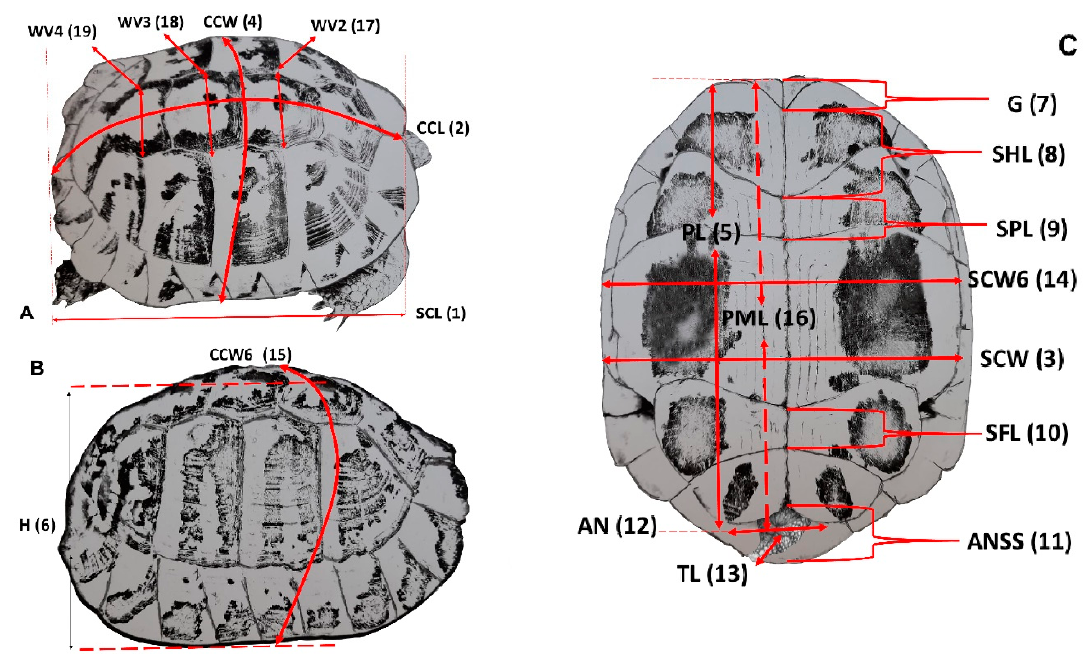
Figure 2. Measurement parameters of the carapace and plastron of T. h. boettgeri . Abbreviations are defined in the Materials and Methods section. The numbers in parentheses indicate the parameter number. ( A , B ) indicate carapace measurements, ( C ) indicates plastron measurements.